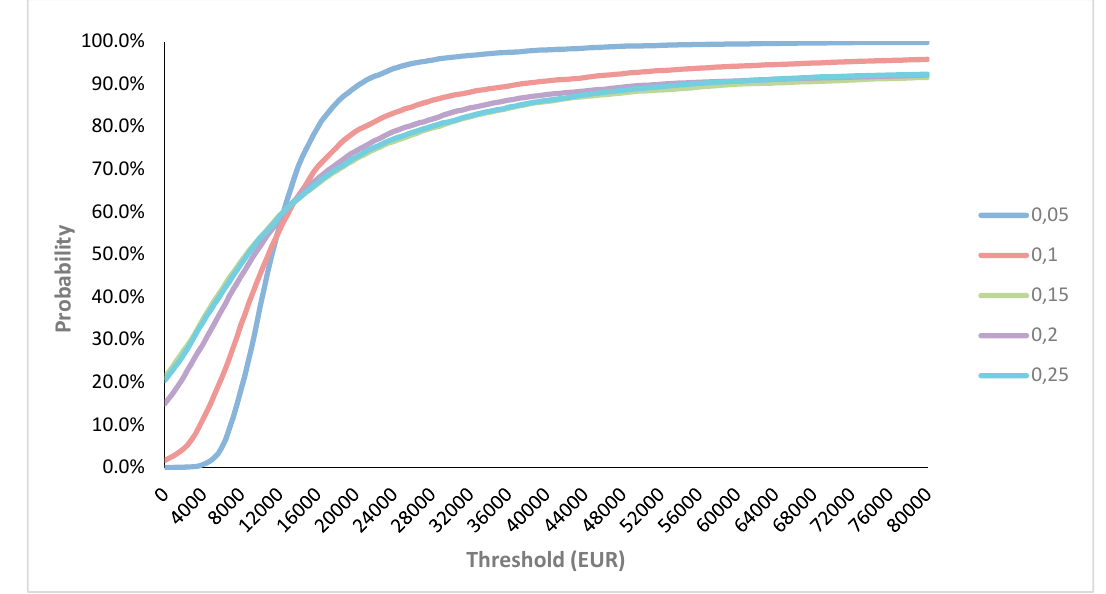
Figure A1. Cost-effectiveness acceptability curve of MDT versus surveillance. In order to evaluate the uncertainty of the input variables, the standard error of the mean was varied: mean * magnitude, with magnitude 0.05, 0.1, 0.15, 0.20, and 0.25. The results were robust, with MDT versus surveillance being cost-effective at a willingness-to-pay threshold of 40,000 euro in respectively 98%, 90.7%, 85.9%, 87.6%, and 86.2% of the iterations. MDT: Metastasis-directed therapy.